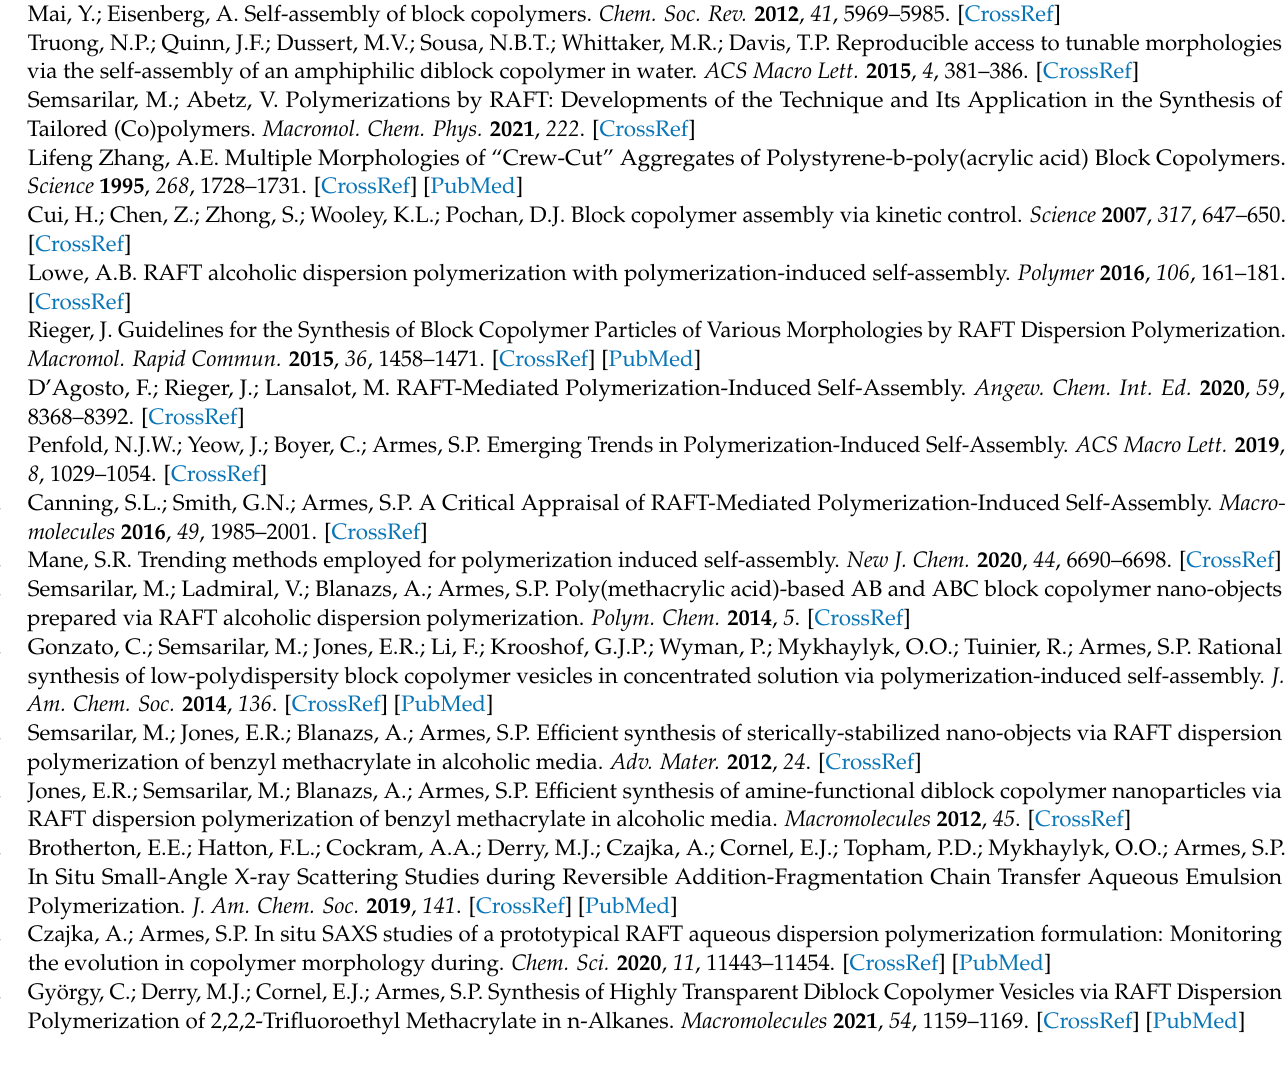
macro-CTA. Table S1: Summary of assemblies focusing on HCFDDMA, Table S2: Summary of the different copolymers synthesized and their dimensions, Table S3: Summary of selected copolymers molecular weights and dipersities obtained from THF SEC calibrated with PS